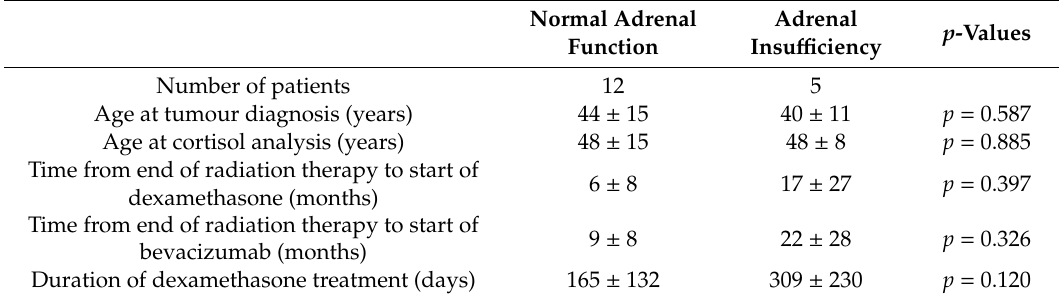
Table 1. Comparison of the patients with and without adrenal insu ffi ciency.